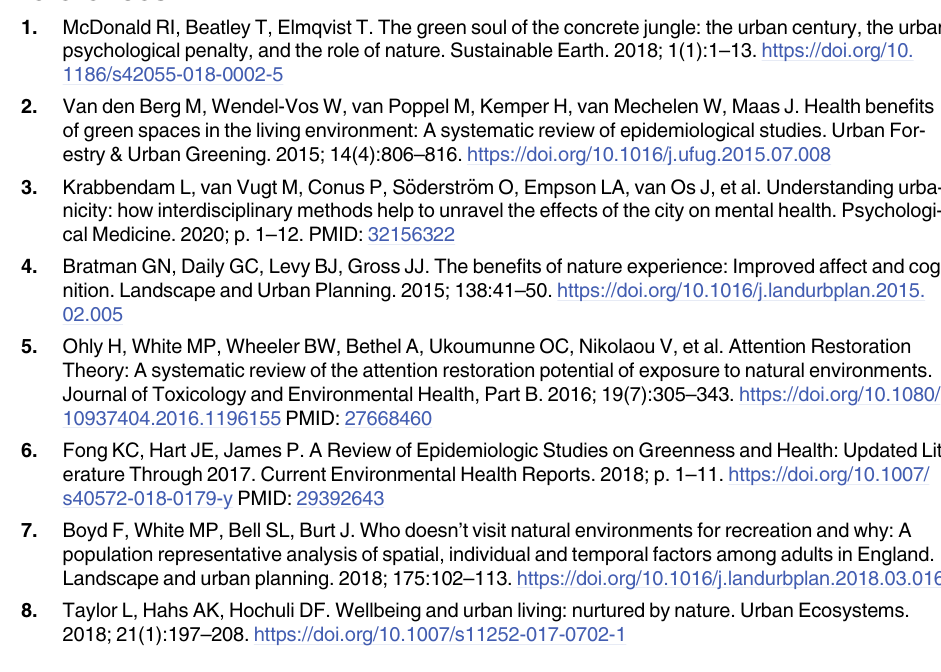
from measures of park acreage, access, investment, and amenities, and is scaled to a maximum score of 100. S4 Fig. Change in happiness benefit by hour of day. The range is the full range of happiness benefit estimates from 10 runs, sampling 80% of tweets. 1,000 random in-park tweets were pooled in each group from each city. Control tweets were selected as tweets most temporally proximate to the in-park tweet from the same